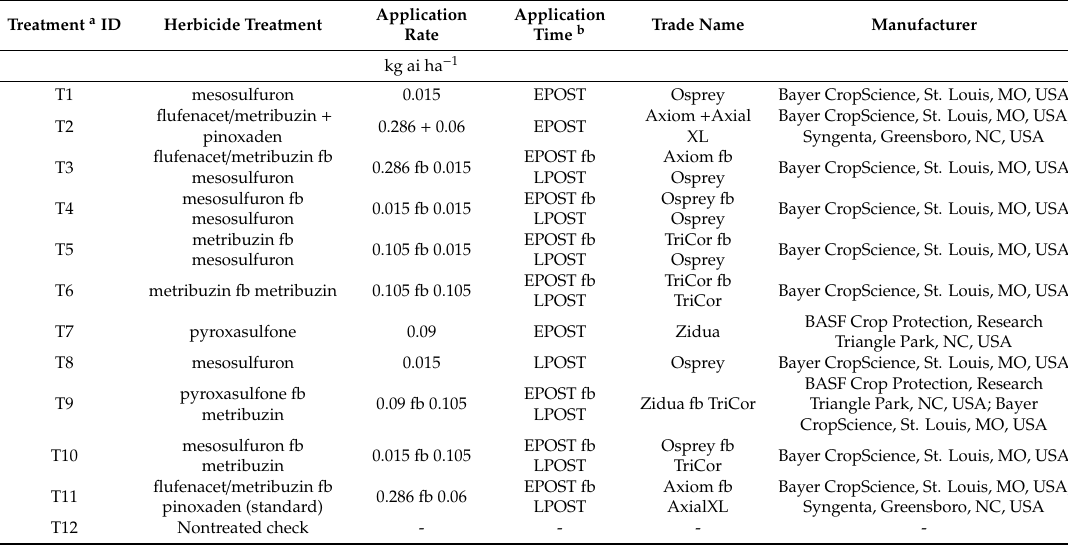
Table 1. Herbicide treatments for the glyphosate-resistant Italian ryegrass control study in Stoneville, Mississippi from 2016 to 2017 a